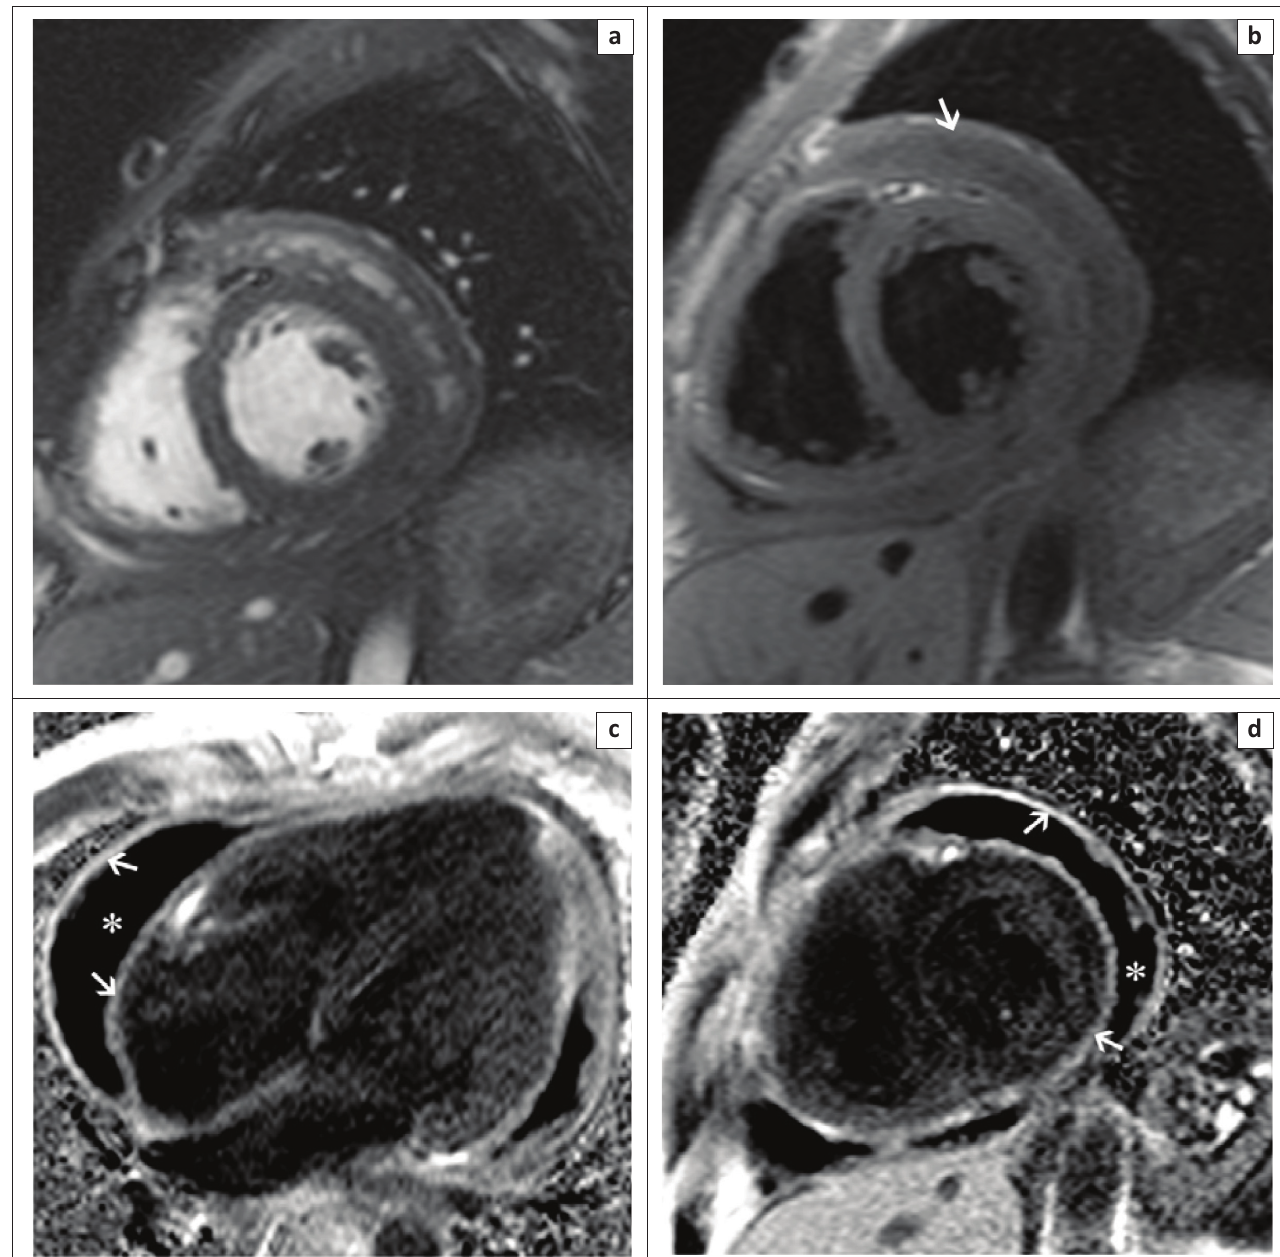
FIGURE 8: Short-axis SSFP (a) and T1-weighted (b) images demonstrate the presence of a large pericardial effusion (white arrow) and marked thickening of the visceral and parietal pericardium. Four-chamber (c) and short-axis (d) late gadolinium images show intense enhancement of the thickened visceral and parietal pericardium (white arrows) and the large hypointense pericardial effusion (white